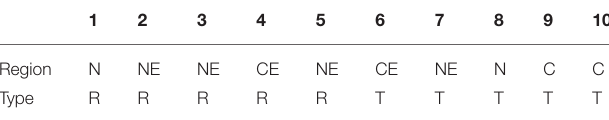
TABLE 1 | Information of the selected sites.